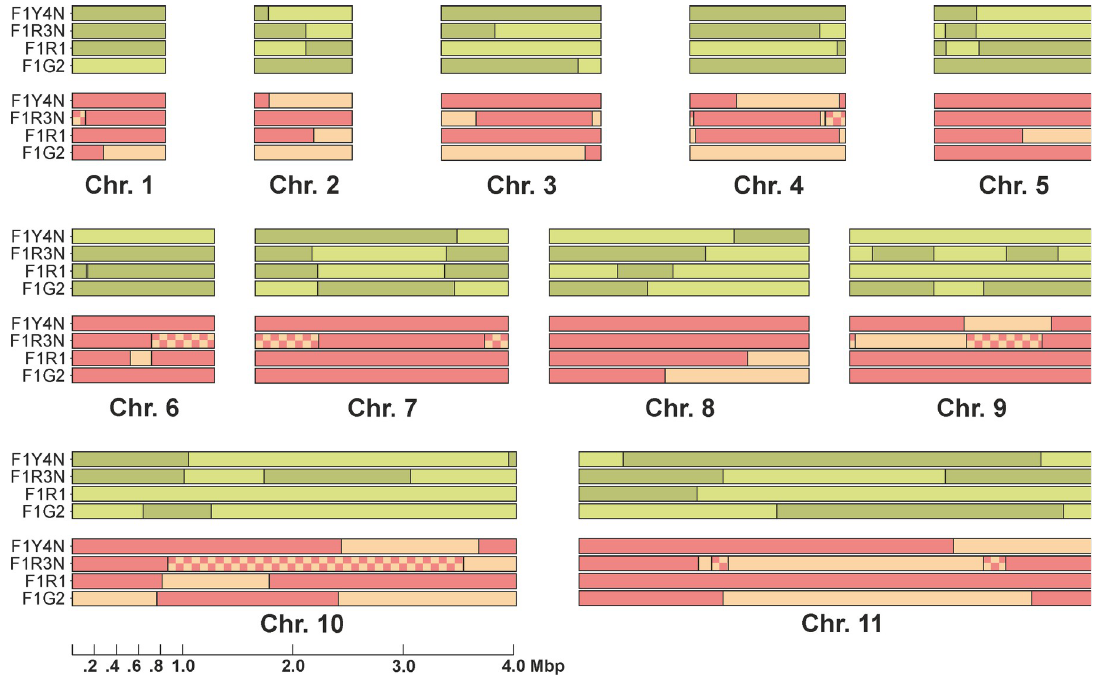
Fig 2. Pattern of inheritance of parental SNPs in four hybrid progeny clones. The core regions of the 11 chromosomes containing housekeeping genes are shown to scale. The two homologues from parent T . b . brucei 1738 are depicted in two shades of green, while those from J10 are red/orange. There is evidence of at least one crossover for most chromosomes as portions of both parental homologues are present in the chromosomes of the hybrids. The chequered blocks show regions where SNPs from both parental homologues were present. More detailed introgression maps are shown in S2 Fig